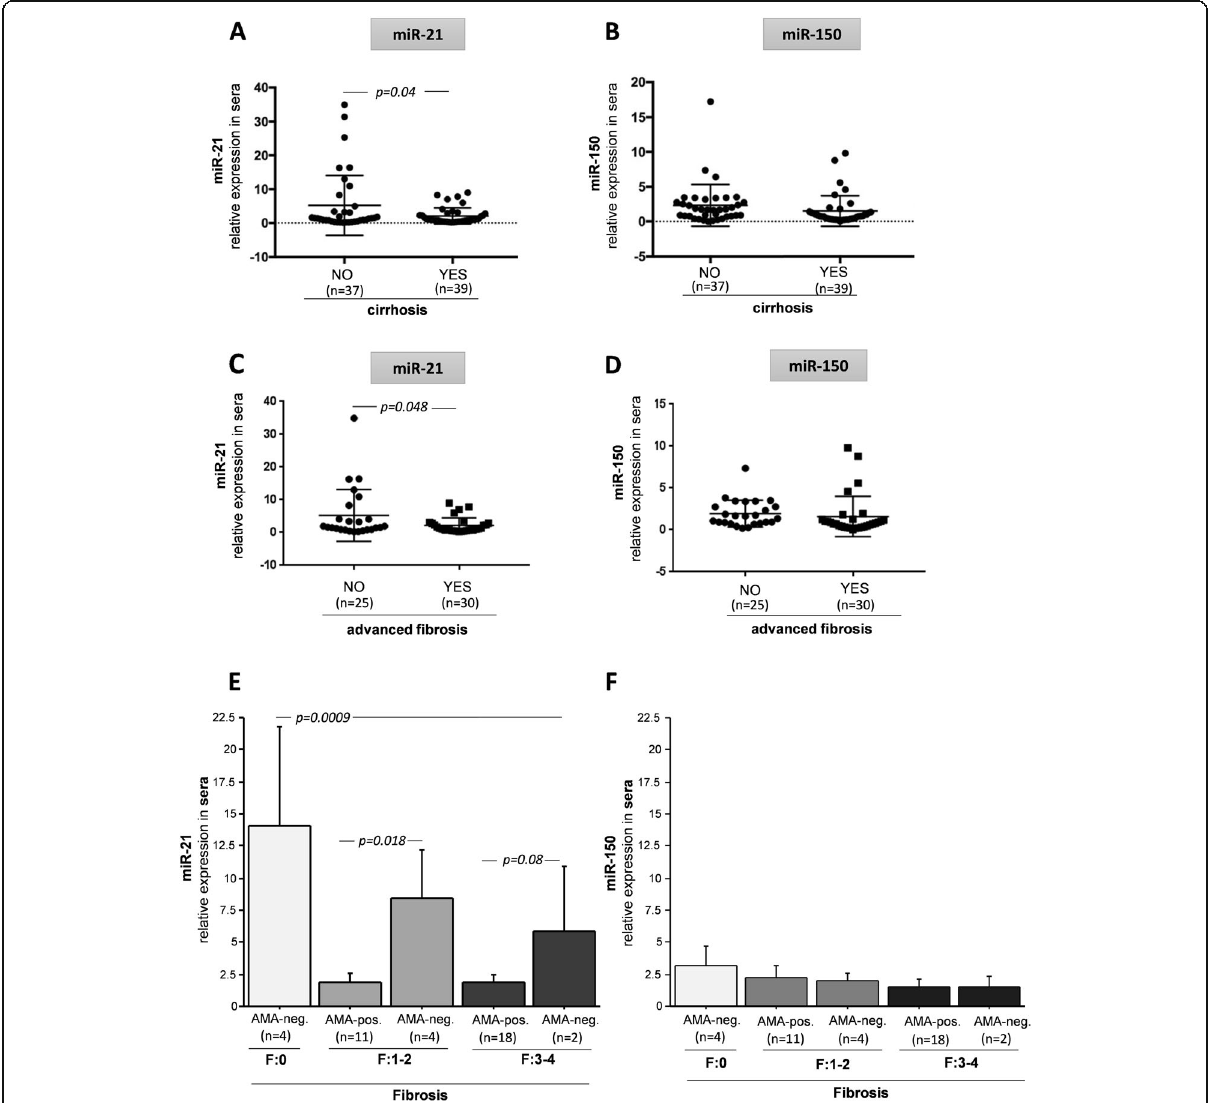
Fig. 2 The relationships between the occurrence of cirrhosis, the stage of fibrosis and serum levels of miR-21 or miR-150. The lower expression of miR-21 was observed in PBC patients with cirrhosis in contrast to non-cirrhotic patients ( a ), in regard to miR-150, there was no difference between cirrhotic and non-cirrhotic patients ( b ). PBC patients without advanced fibrosis had the higher level of miR-21( c ), whereas the level of miR-150 was comparable among all PBC patients independently of fibrosis status ( d ). In contrast to miR-150 ( f ), miR-21 expression changes dependently of fibrosis stages ( e ). Bars indicate the mean ±